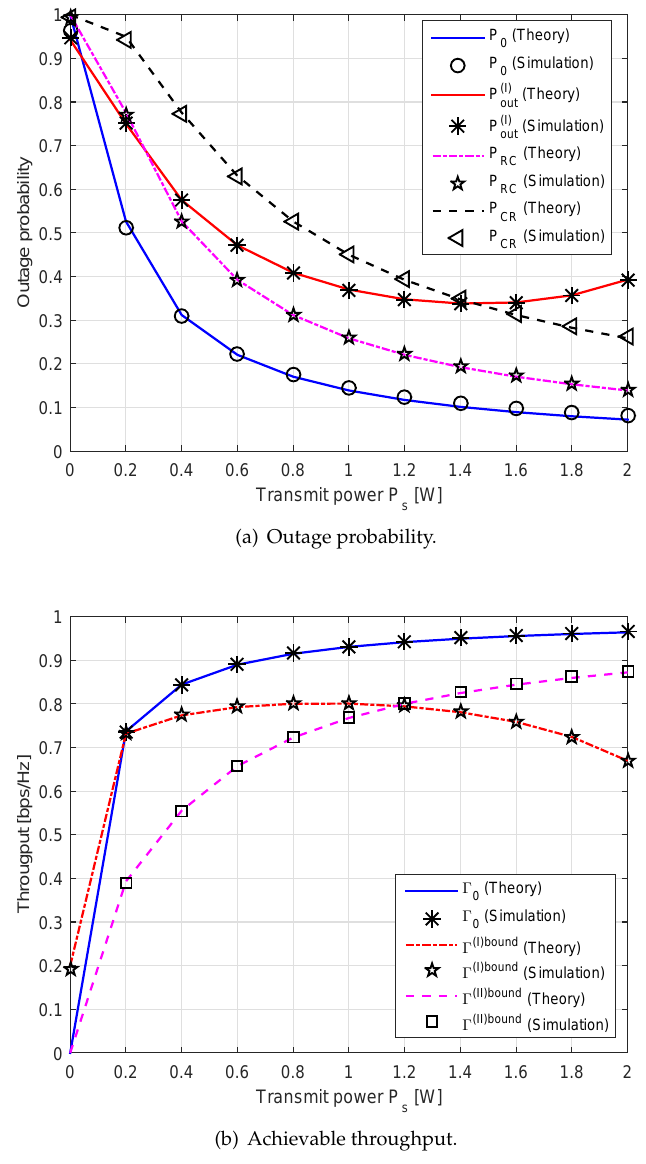
Figure 4. The outage probability and the throughput performance versus the transmit power P s